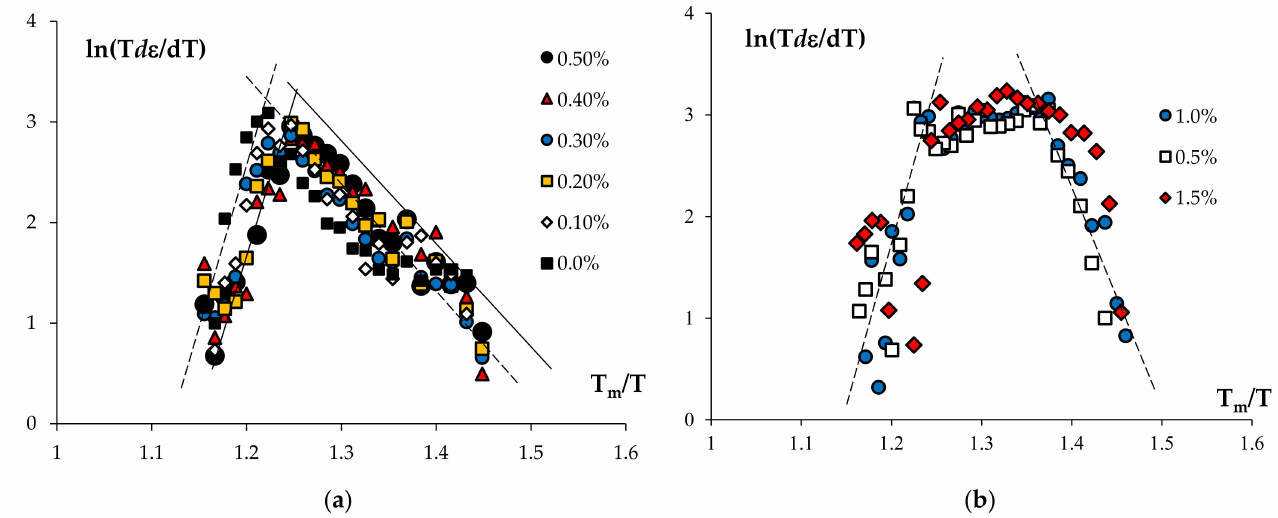
Figure 12. Dependence of shrinkage on the reciprocal temperature of sintering of submicron ( a ) and nanopowder ( b ) α -WC+10 wt.%Co compositions with various graphite concentrations. Determination of the sintering activation energy at “mid-range”